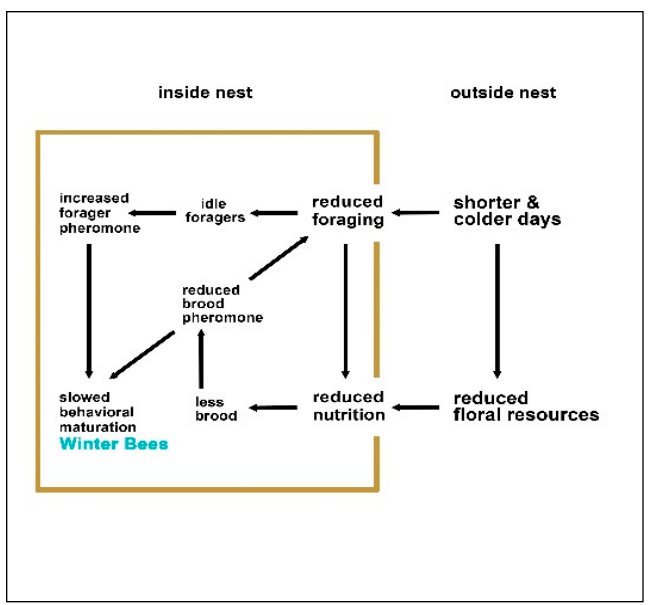
Figure 1. The model presented in Gunter’s review article.